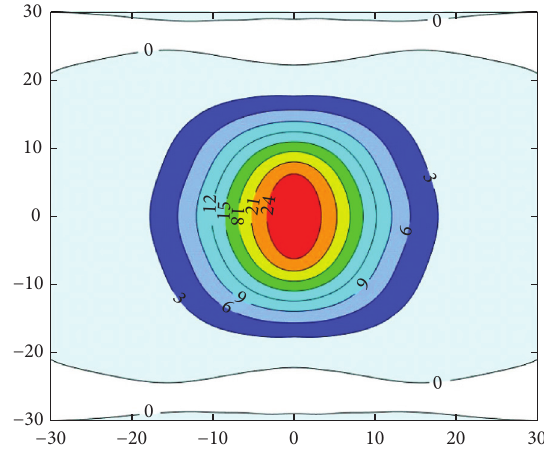
Figure 20: Contour figure of ground frost heave caused by freezing for 90 days (mm, α � 0 ° ).